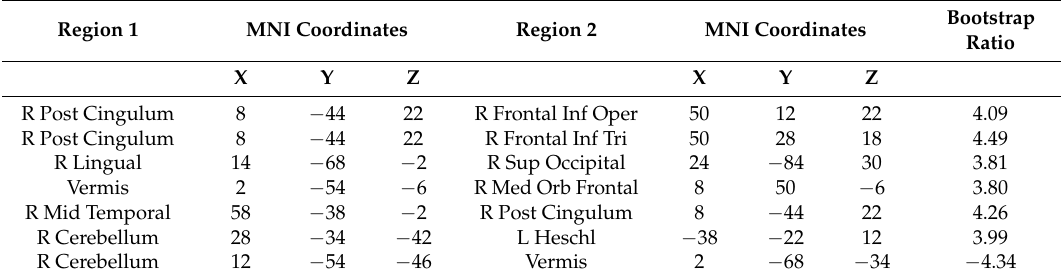
Table A2. Areas of altered functional connectivity observed among individuals with MCI associated with increased lane deviations.